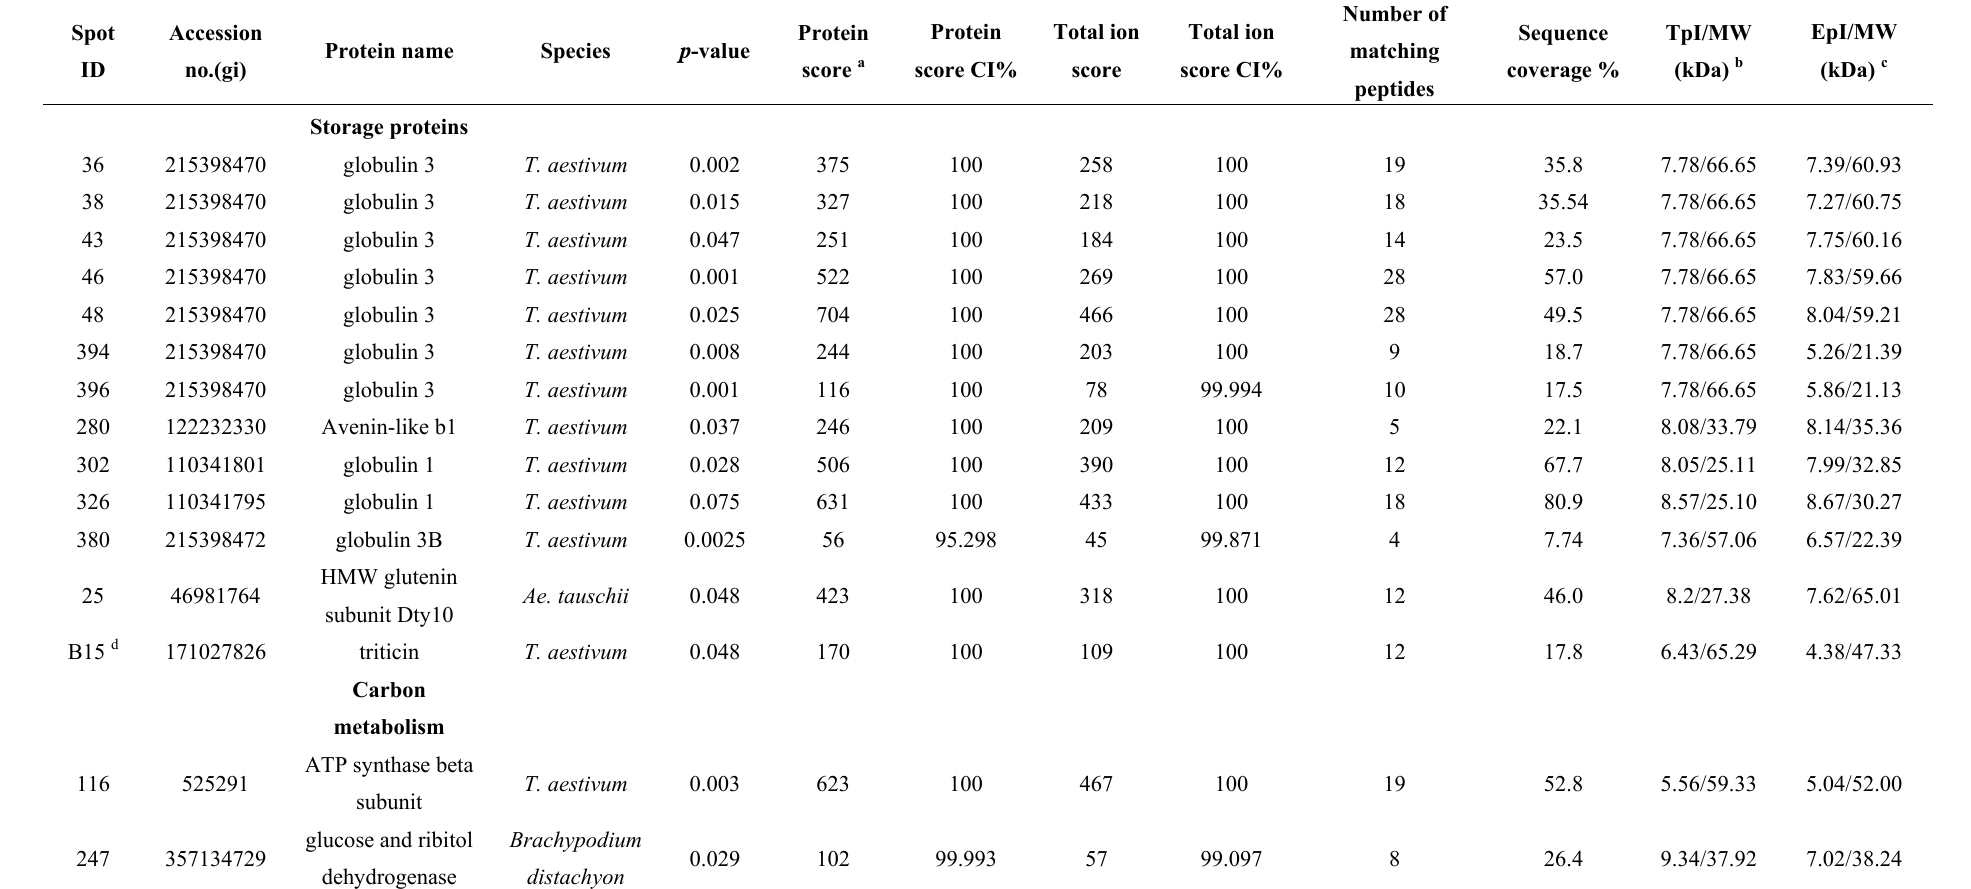
Table 1. Proteins differentially expressed in the mature seeds of CS and